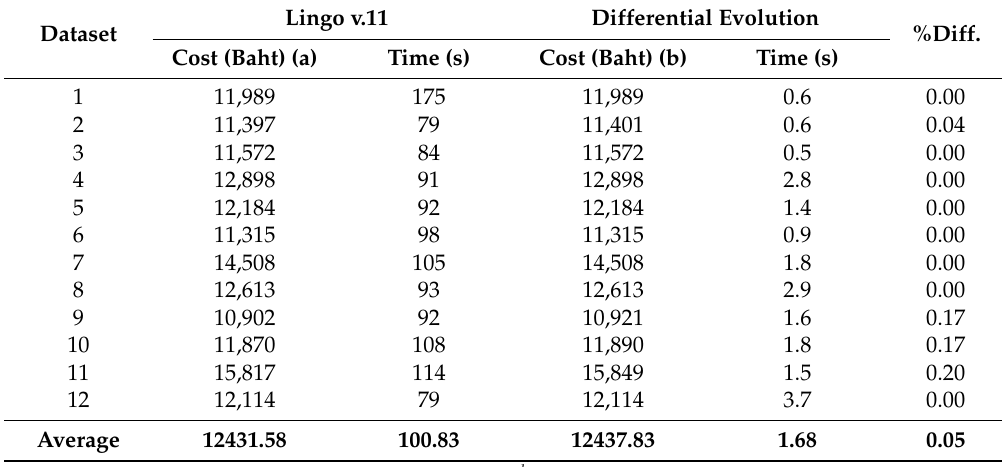
Table 18. Experimental results of the medium sample (10 × 10) showing cost of assignment and processing time.